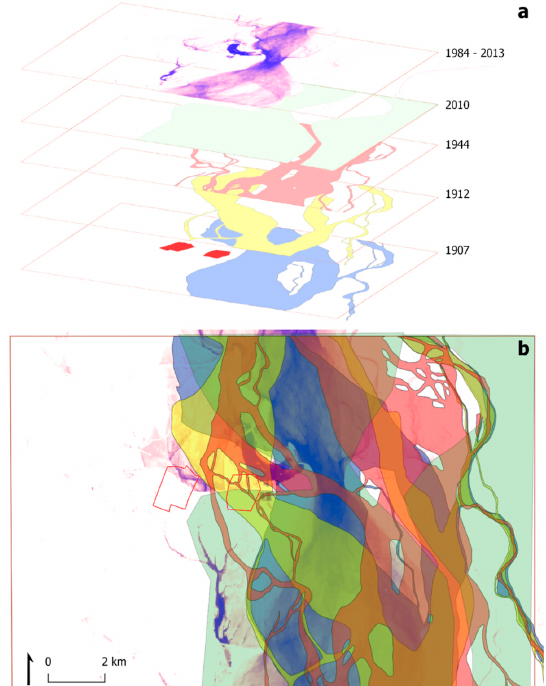
Figure 12. ( a ): active channels of the Indus documented in different historical moments. SoI 1” to 1-mile editions of 1907, 1912 and 1944. It have been add the extension of the 2010 flood extracted from MODIS (see Figure 3) and the surface water occurrence layer from Global Surface Water Explorer [50,51]; In the image below ( b ) the different documented historical extensions of the Indus riverbed are superimposed in a single